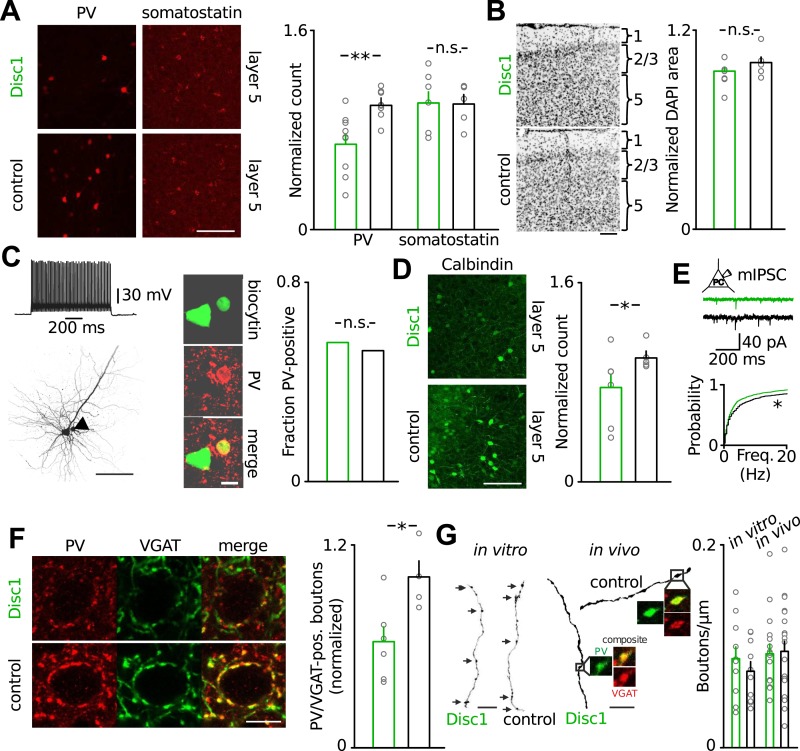
Loss of FS-INs and their output synapses in the Disc1 PrlC.(A) Reduction of PV but not somatostatin-positive INs in the PrlC of Disc1 mice (normalized count PV: 0.69 ± 0.08 vs 1.00 ± 0.04, n = 9 Disc1, 8 control mice, p = 0.0037; somatostatin: 1.04 ± 0.10 vs 1.00 ± 0.08, n = 6, 5, p = 392). (B) Total cell density quantified from DAPI area is unchanged (normalized density: 0.93 ± 0.04 vs 1.00 ± 0.04, n = 6, 5 mice, p = 0.158). (C) FS-INs of Disc1 and control mice express PV (n = 25, 29 cells). (D) Expression of the FS-IN marker calbindin is reduced in Disc1 PrlC (0.75 ± 0.12 vs 1.00 ± 0.05, n = 6, 5 mice, p = 0.027). (E) Frequency of mIPSCs recorded in PCs was significantly reduced in the Disc1 PrlC (0.73 ± 0.14 vs 1.18 ± 0.23 Hz, n = 24, 5 cells, p = 0.025). (F) Fewer PV-VGAT-coexpressing boutons in Disc1 mice (normalized count 0.62 ± 0.09 vs 1.00 ± 0.10, n = 6, 4 mice, p = 0.021). (G) Identical bouton density of intracellularly labelled FS-INs in vitro (0.09 ± 0.01 vs 0.07 ± 0.01 µm−1, n = 12, 10, p = 0.388) and PV-positive cells in vivo (0.09 ± 0.01 vs 0.09 ± 0.01 µm−1, n = 16, 20, p = 0.868). *p < 0.05, **p < 0.01. Scale bars: A, B, C (left), D: 100 µm, E: 25 µm, C (right): 10 µm. Data are mean ± SEM, circles individual mice or cells (C and F).